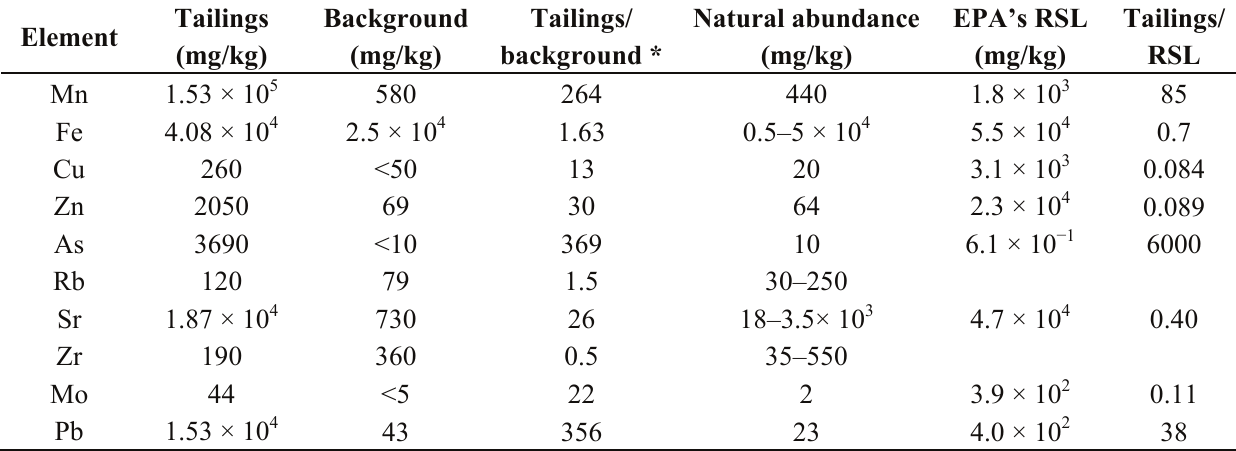
Table 1. Concentrations of the elements in the tailings, “background”, tailings/“background”, natural abundance [31], U.S. Environmental Protection Agency’s (EPA’s) RSL (Regional Screening Levels) and the tailings/RSL